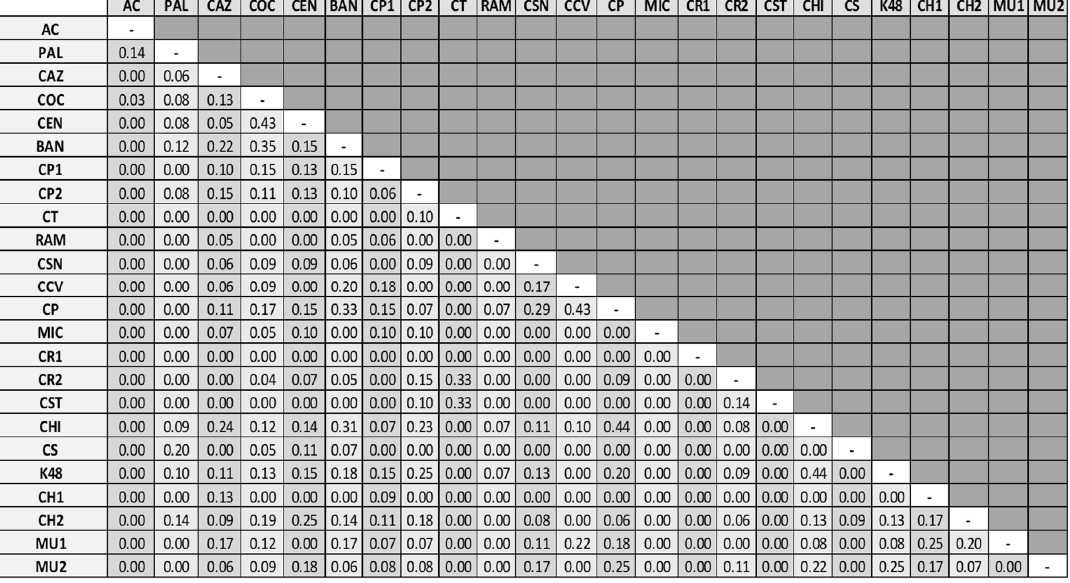
Figure A1. Matrix of Jaccard index values for all pairs of sampled locations, based on water mite BINs. AC = Acapulquito, PAL = Palmar, CAZ = Cenote Azul, COC = Cenote Cocalitos, CEN = Cenote Escuela Normal, BAN = Bacalar Norte, CP1 = Cenote Pucte 1, CP2 = Cenote Pucte 2, CT = Cenote El Toro, RAM = Ramonal, CSN = Cenote Sijil Noh Ha, CCV = Cenote Chancah Veracruz, CP = Cenote del Padre, MIC = Minicetonte, CR1 = Cenote Tres Reyes 1, CR2 = Cenote Tres Reyes 2, CST = Cenote Santa Teresa, CHI = Chichancanab, CS = Cueva de las serpientes, K48 = Cenote Km.48, CH1 = Chunyaxche 1, CH2 = Chunyaxche 2, MU1 = Muyil 1, and MU2 = Muyil 2.